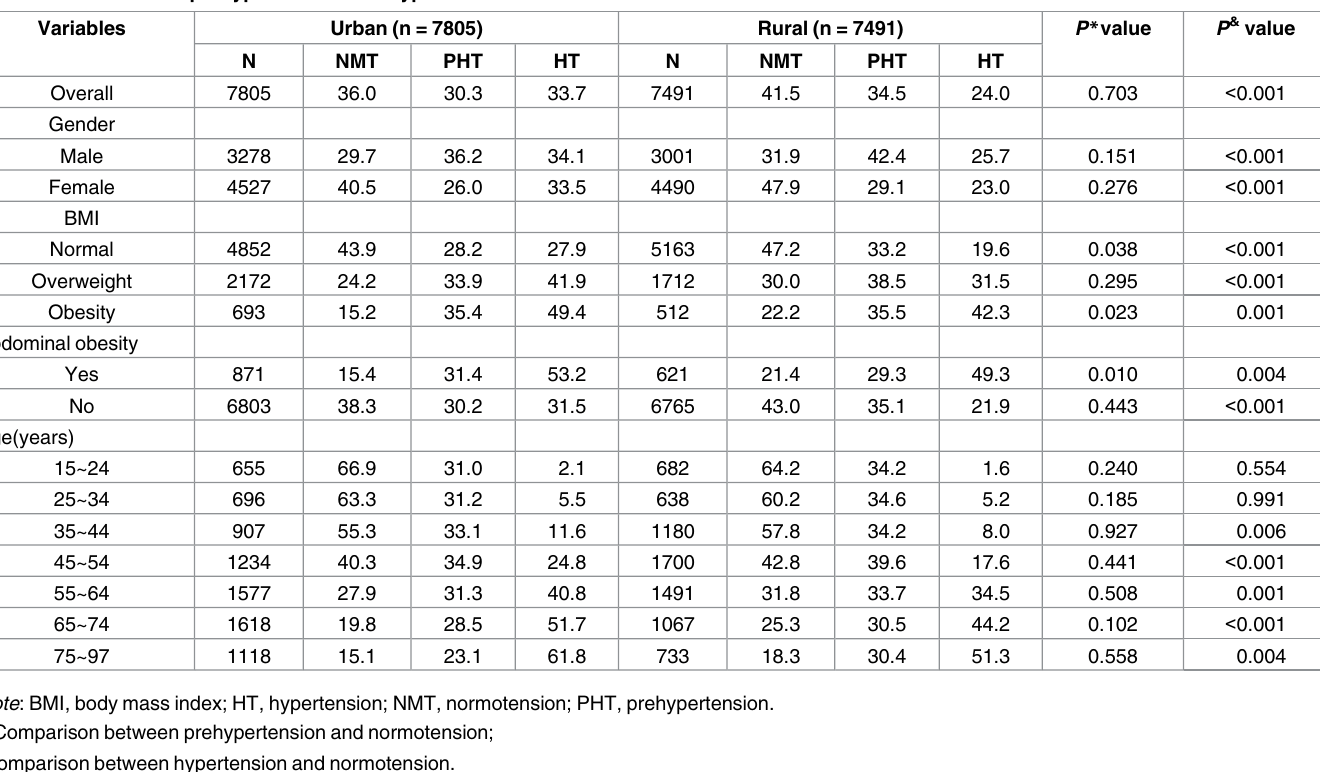
Table 4. Prevalence of prehypertension and hypertension in urban and rural areas.